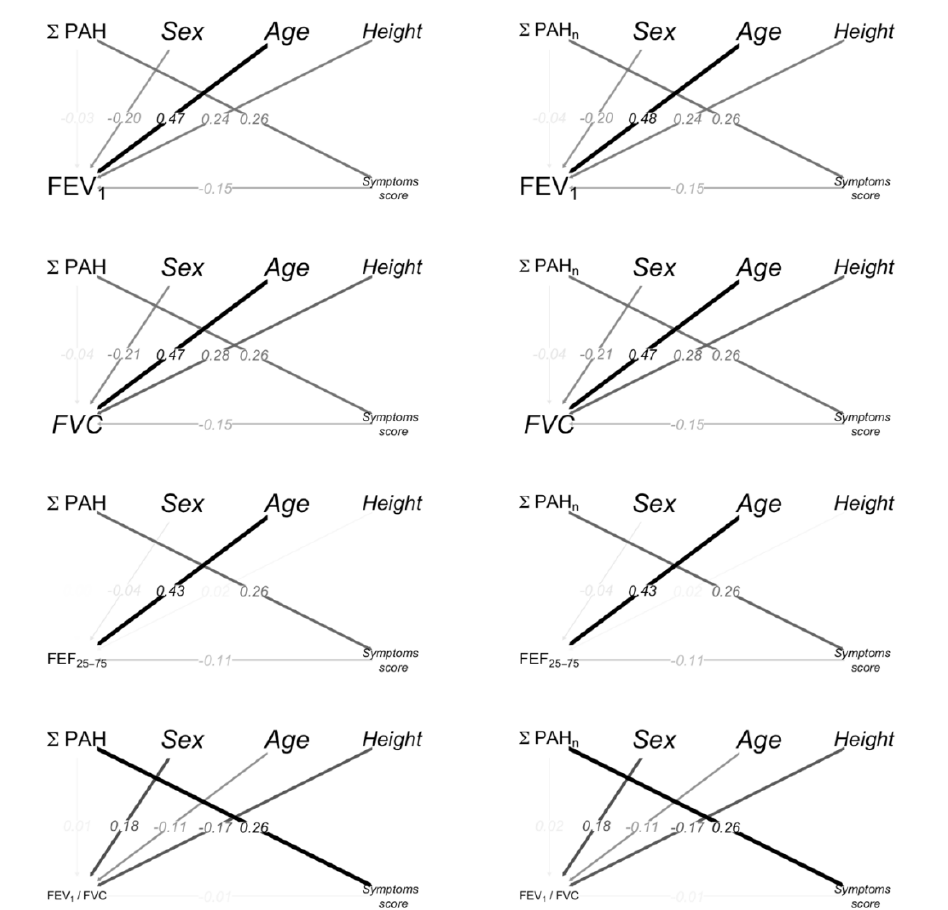
Figure 2. Path diagrams. The black/gray color intensity and the width of the arrows is proportional to the magnitude of the effects. The arrows from PAHs to spirometry represent the direct effects. The path from PAHs to spirometry through symptom score highlights the indirect effects. The arrows are labeled with the standardized coefficients of the Mediation Analysis. The standardized coefficients represent the degree of change in the outcome variable for every 1-unit of change (for quantitative predictors) or switching from one category to the other (for dichotomous predictors) in the predictor variable.